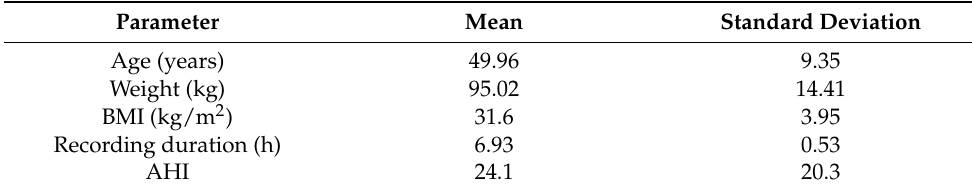
Table 2. Summary of the PhysioNet